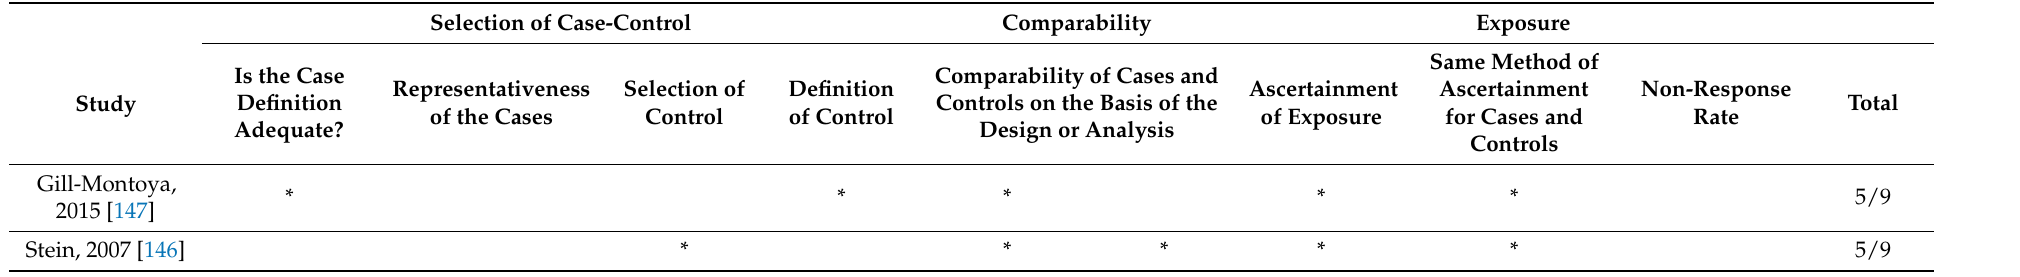
Table 6. Quality of case-control studies assessed using the Newcastle–Ottawa